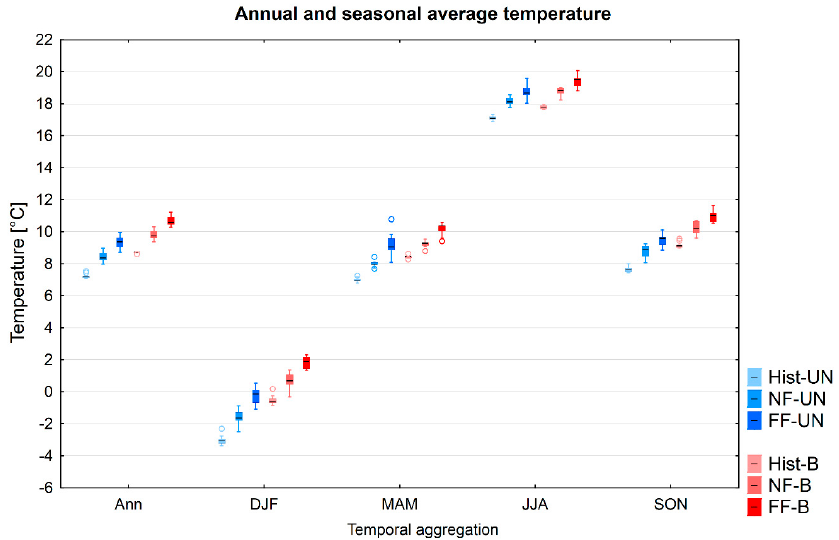
Figure 4. Multi-model ensemble projections of annual and seasonal average temperature for the near (NF) and the far (FF) future under RCP 4.5 in comparison to the historical (Hist) period. B stands for the Barycz catchment and UN stands for the Upper Narew catchment.